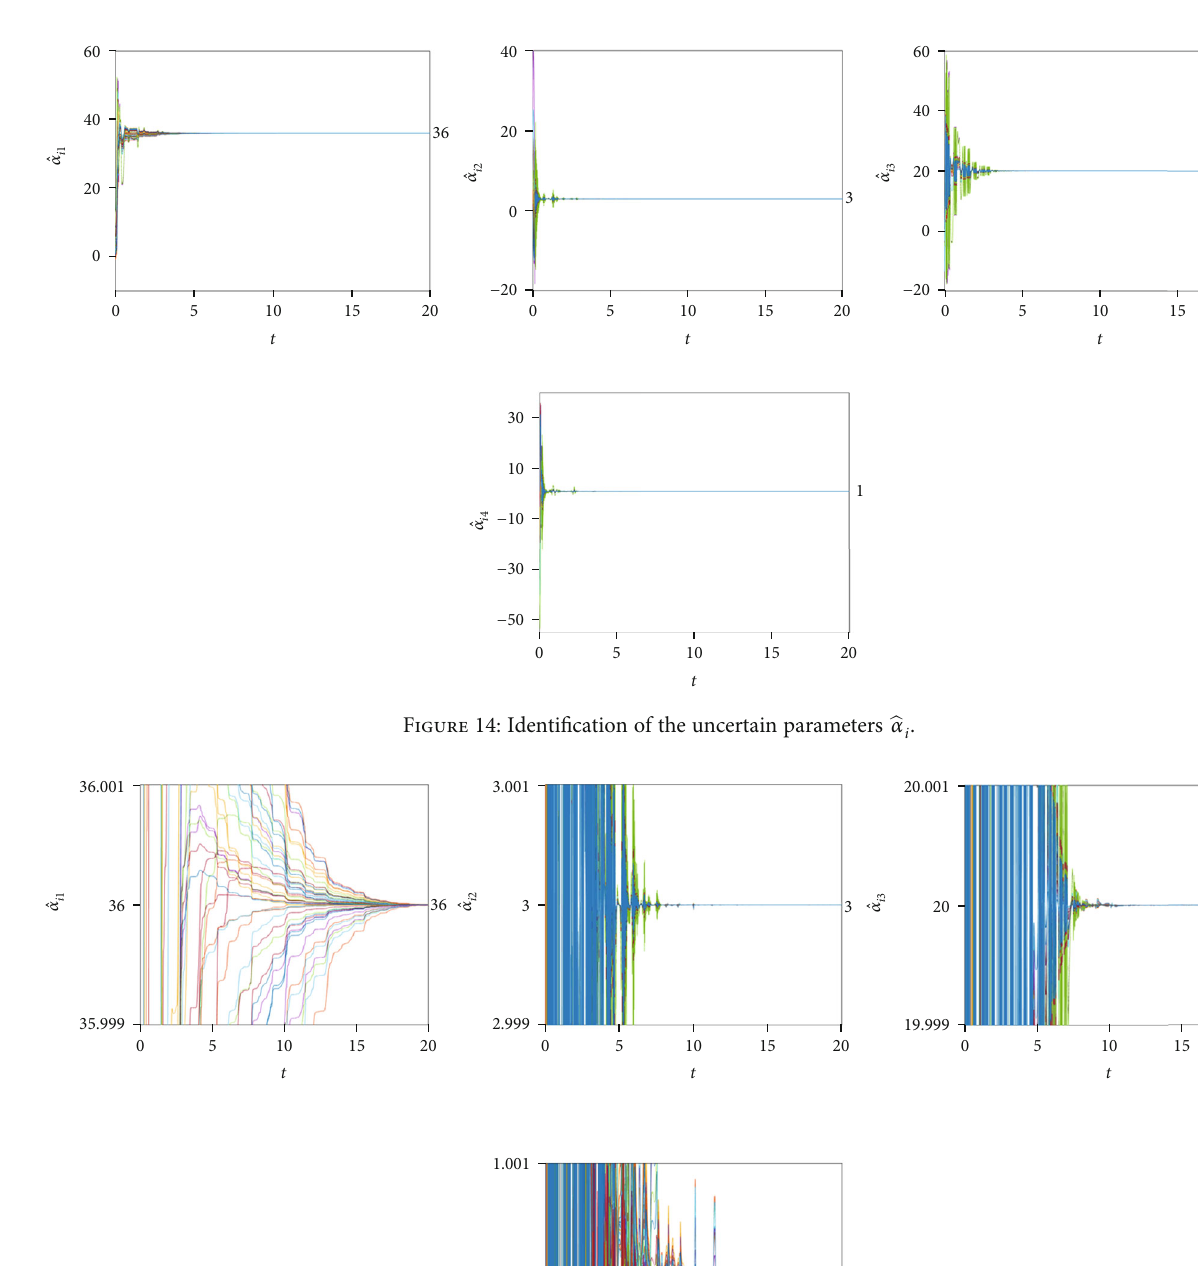
Figure 15: Partial ampli fi cation of the uncertain parameters b α